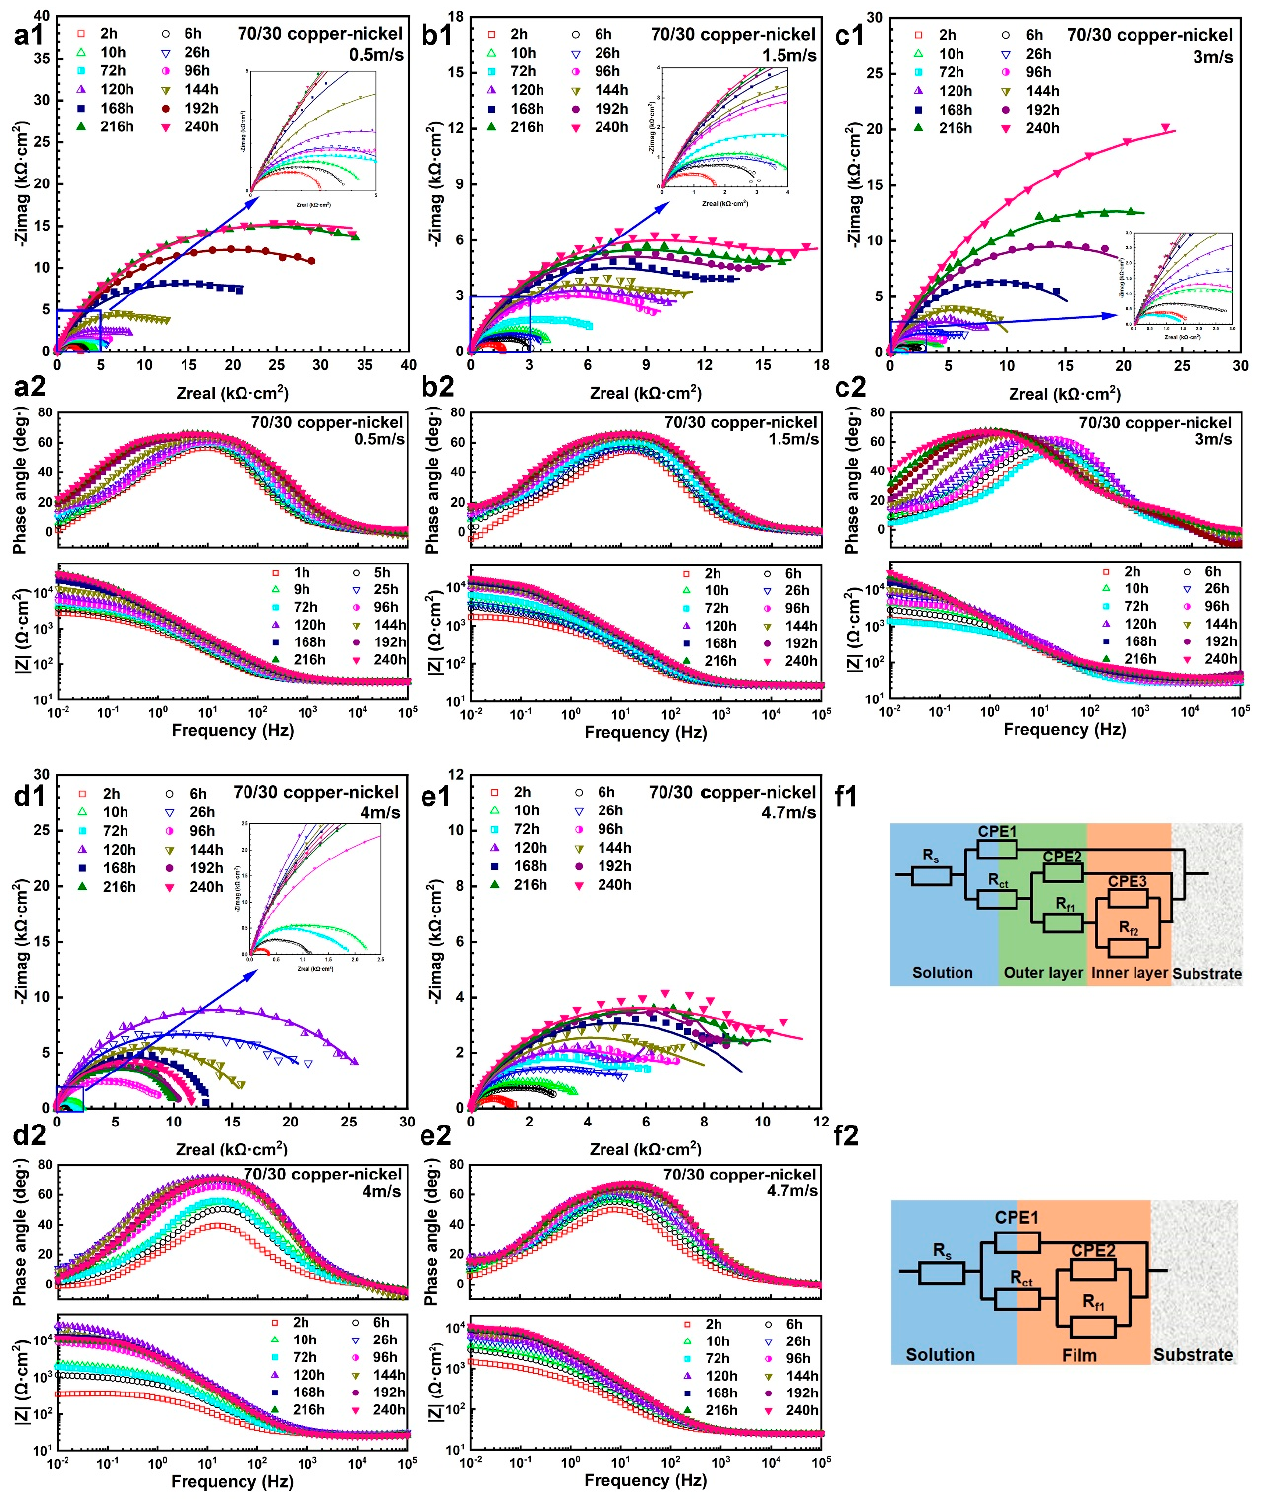
Figure 3. Nyquist plots and Bode plots of the 70/30 samples monitored during the 10-day erosion– corrosion tests at the flow velocities of 0.5 m/s ( a1 , a2 ), 1.5 m/s ( b1 , b2 ), 3 m/s ( c1 , c2 ), 4 m/s ( d1 , d2 ), and 4.7 m/s ( e1 , e2 ); the equivalent circuits used for EIS fitting tested at lower flow velocities of 0.5 m/s and 1.5 m/s ( f1 ) and at higher flow velocities of 3 m/s, 4 m/s, and 4.7 m/s ( f2 ). Table 2. Electrochemical parameters of 90/10 copper–nickel samples obtained by fitting EIS curves.